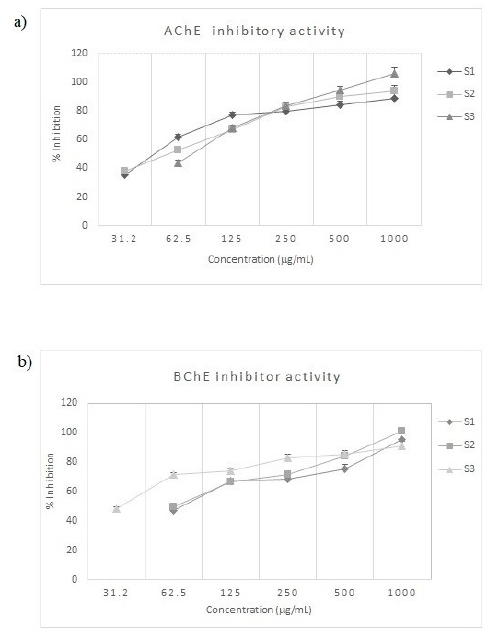
Figure 3. ( a ) Acetylcholinesterase (AChE) and ( b ) butyrylcholinesterase (BChE) inhibition by S. officinalis essential oils (S1–S3). Data are expressed as means ± S.D. ( n = 3).